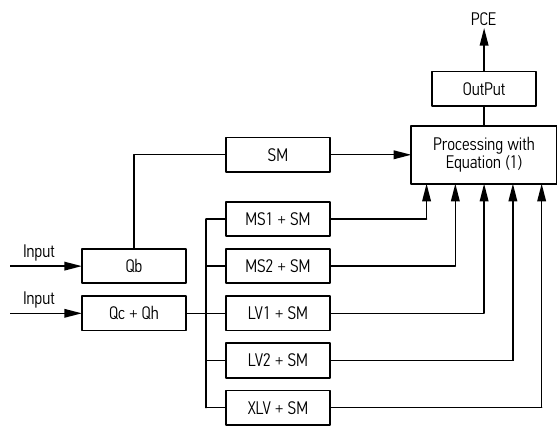
Fig. 3. Logical framework for the selection of the ranges